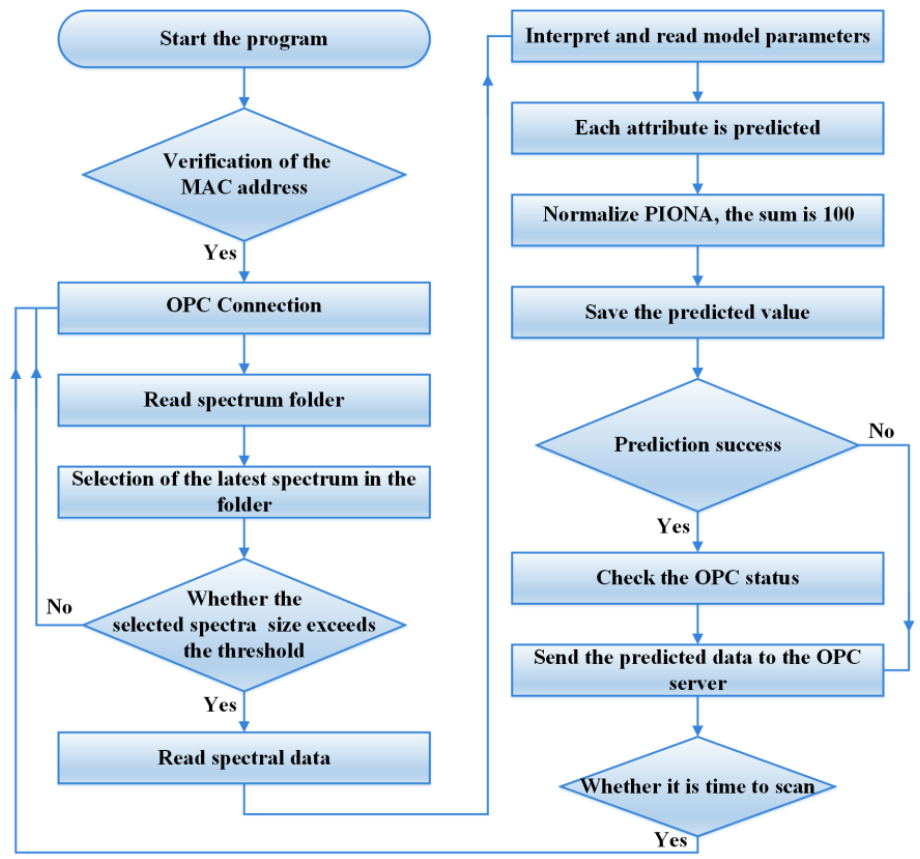
Figure 8. Program logic flow chart of the online NIR analysis system.